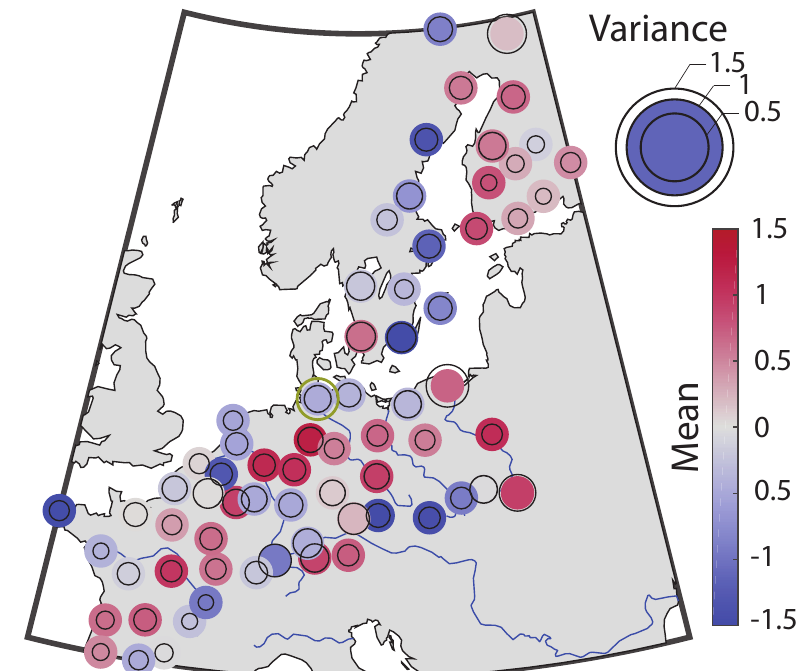
Figure A8. Illustration of the performance of the cross-validation with the mean and variance of the normalized error of estimation (Equation (15)) at each radar location. Negative or positive mean values respectively indicate an under- or overestimation of the model estimation. The reproduction of the variance is illustrated by a black circle: a perfect variance would match the color circle while a smaller circle indicates an underconfidence (uncertainty range too